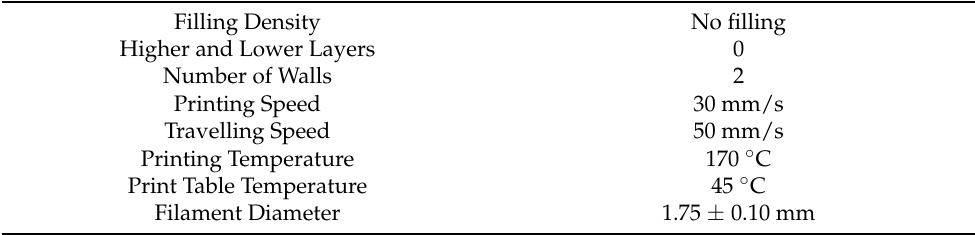
Table 3. Filament printing